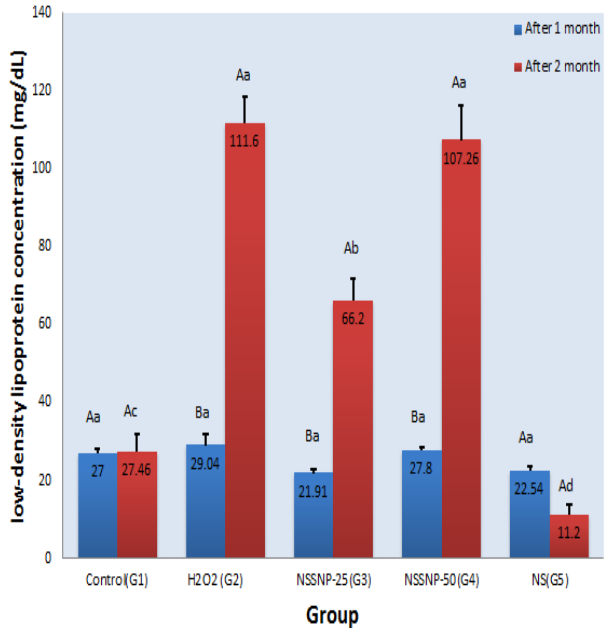
Figure 6. Effect of two concentrations of Nigella sativa seeds silver Nanoparticles NSSSNPs and Nigella sativa extract on serum low-density lipoproteins concentration (mg/dl) in H O exposed rats. Values are expressed as 2 2 mean±SE (n= 8). Various capital letters denote significant differences at P<0.05 between